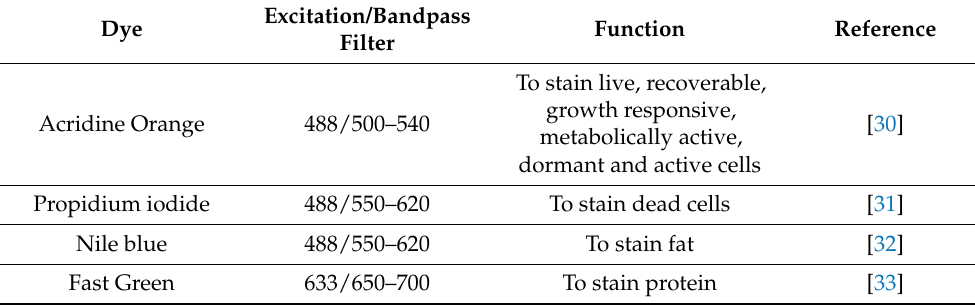
Table 1. List of Dyes and Excitation–Emission Filters used in this